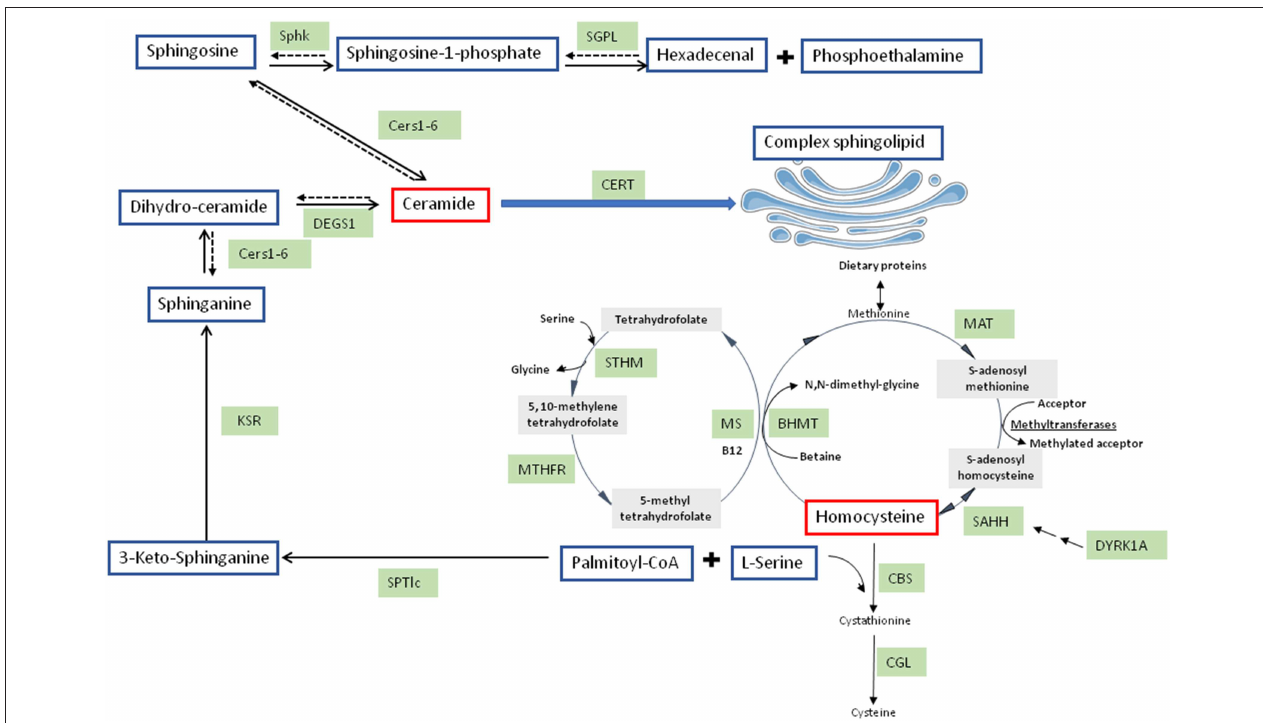
FIGURE 1 | Integrated pathways for homocysteine/cysteine synthesis from methionine and sphingolipid synthesis. BHMT, betaine-homocysteine methyl transferase; CBS, cystathionine beta-synthase; Cers, ceramide synthases; CERT, ceramide transferase; CGL, cystathionine gamma-lyase; DEGS1, dihydroceramide desaturase 1; KSR, 3-keto-sphinganine reductase; MAT, methionine adenosyl transferase; MS, methionine synthase; MTHFR, 5,10-methylene tetrahydrofolate reductase; SAHH, S-adenosyl homocysteine hydrolase; SGPL, sphingosine-1-phosphate lyase; Sphk, sphingosine kinase; SPTlc, serine palmitoyltransferase; STHM, serine